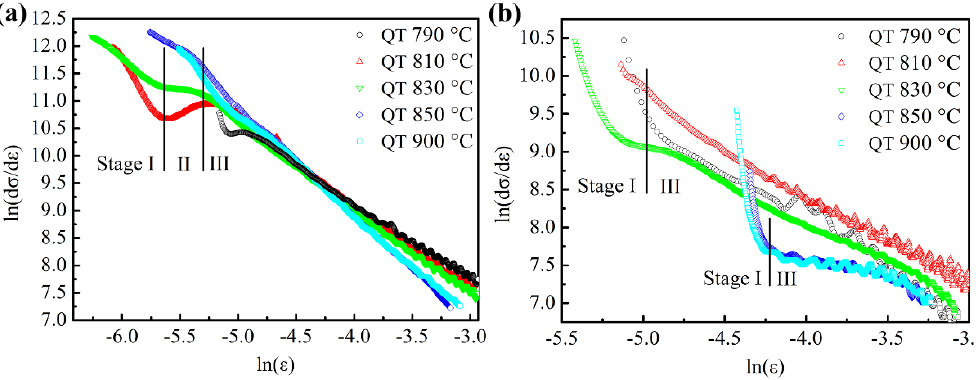
Figure 8. D C–J plots of ln(d σ /d ε ) versus ln( ε ) for specimens quenched from different temperatures and tempered at ( a ) 180 °C and ( b ) 450 °C, respectively.